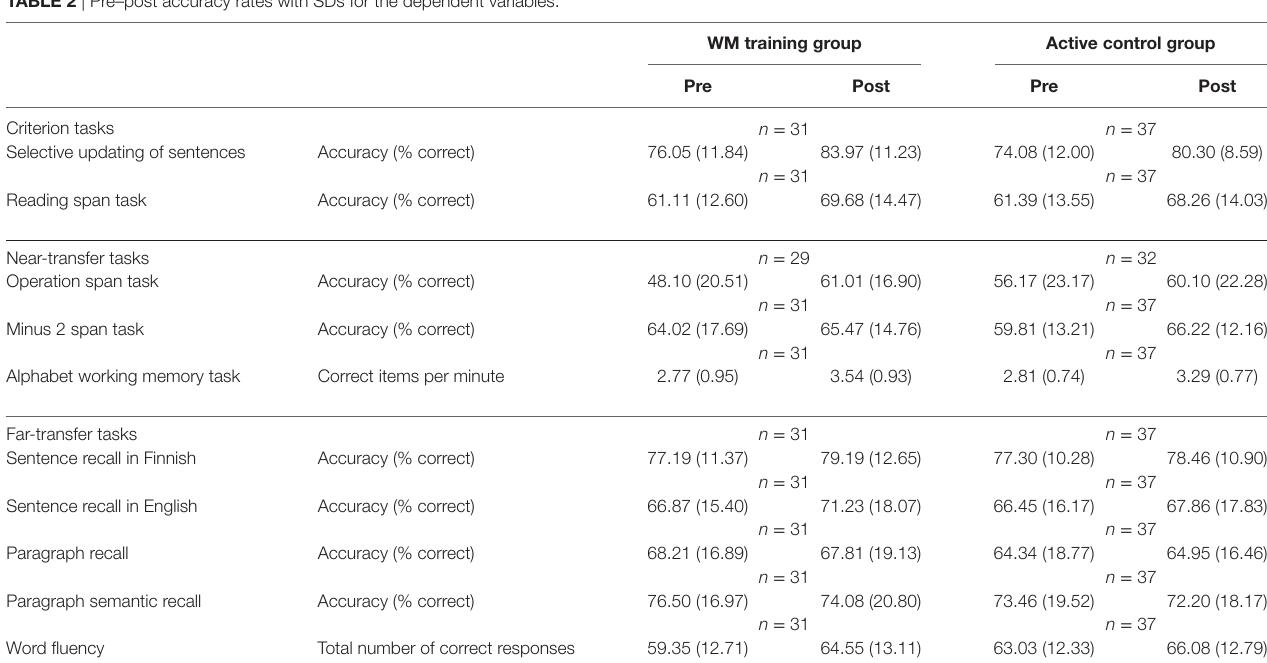
Table 2 | Pre–post accuracy rates with SDs for the dependent